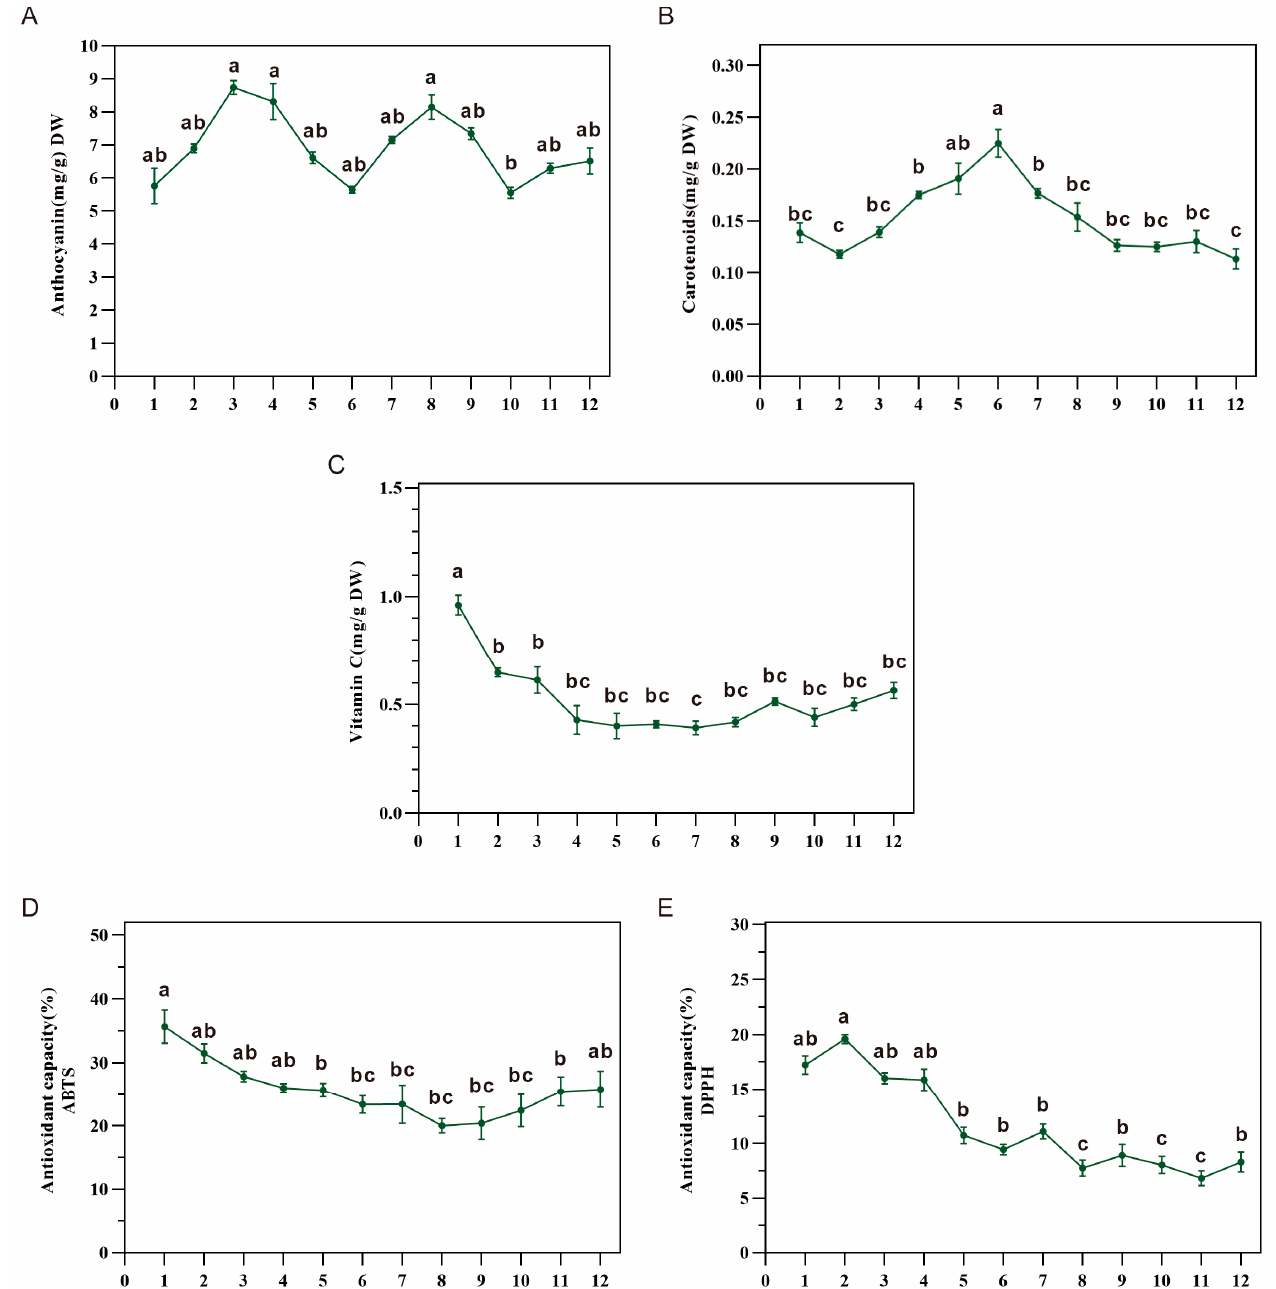
Figure 4. The changes in the contents of anthocyanin ( A ), β -carotene ( B ), and vitamins C ( C ), and in the scavenging abilities of ABTS ( D ) and DPPH ( E ) radicals in the root of C. pilosula during its various growth stages. Values represent means ± SE ( n ≥ 3). DW: dry weight. Different letters above the bars indicate a significant difference ( p < 0.05) by one-way ANOVA with Tukey’s multiple comparison test. We performed a correlation analysis of the contents of CPPs, atractylenolide III, and the expression levels of six genes. The results indicated that the content of atractylenolide III was positively correlated with the expression levels of CpPMK ( R 2 = 0.97) and CpMVD ( R 2 = 0.89). Furthermore, CpUGpase and CPPs exhibited a highly positive correlation ( R 2 = 0.90) (Figure